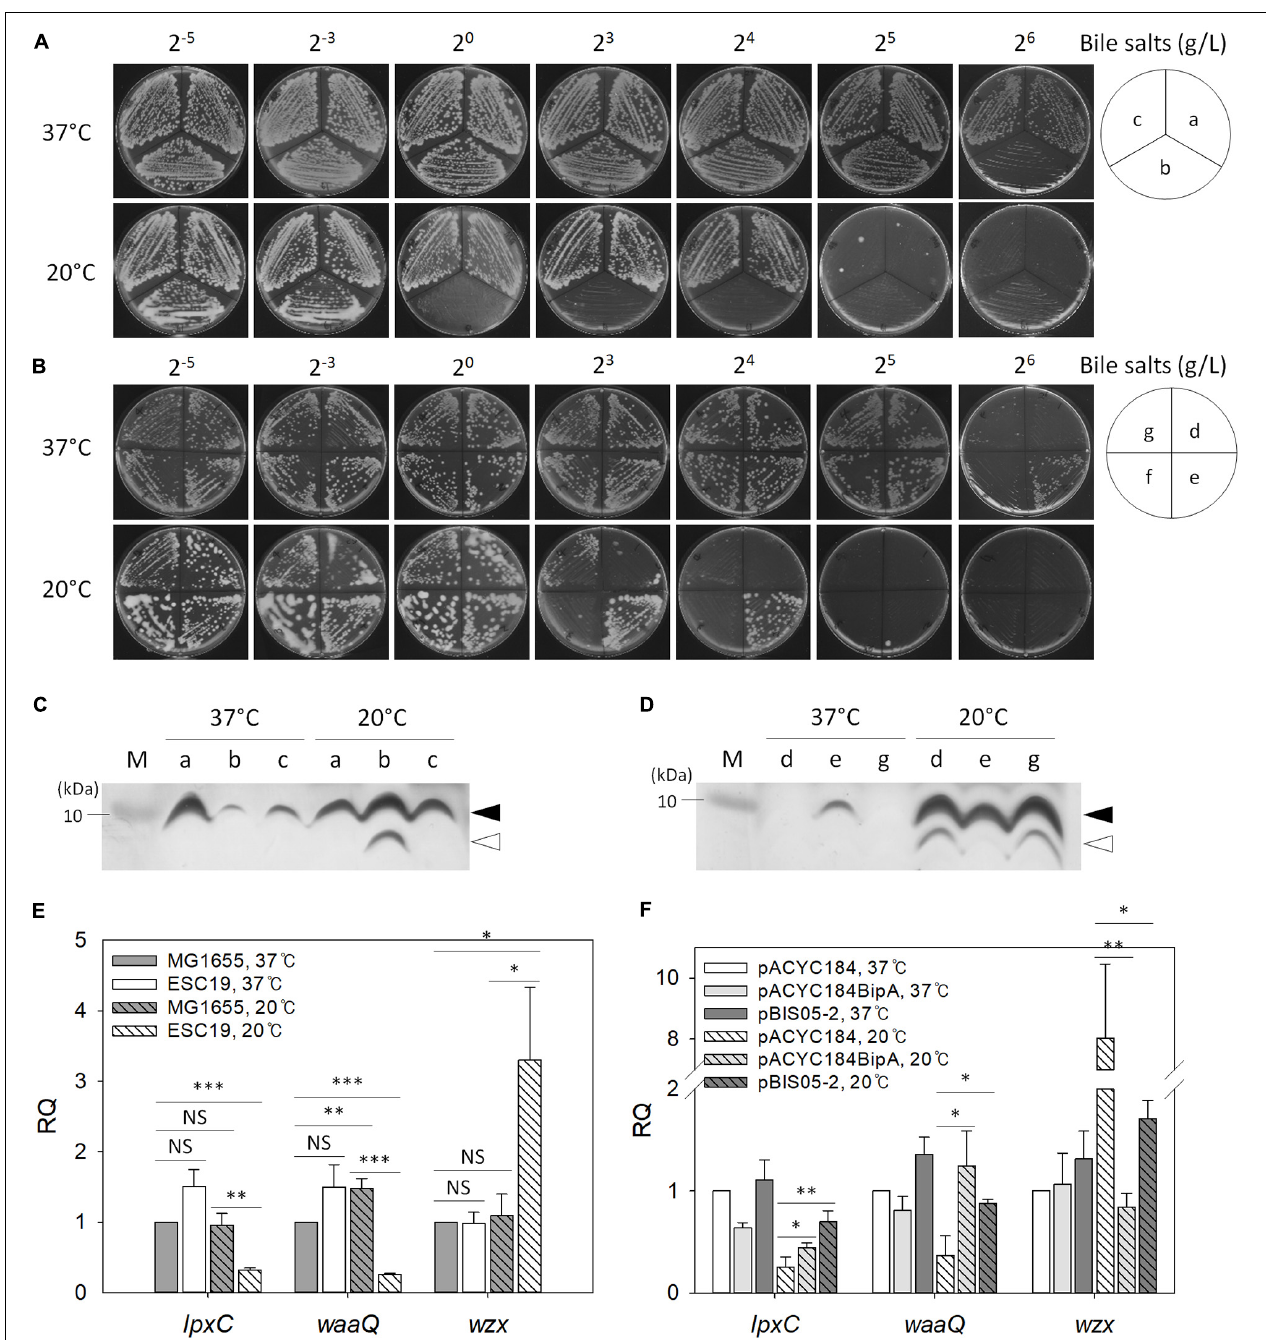
FIGURE 5 | The effect of bipA -deletion on LPS biosynthesis. Overnight cultures of the MG1655, ESC19, and ESC48 strains (A) or the ESC19 transformants with pACYC184, pACYC184BipA, pBIS02-2, or pBIS05-2 (B) were diluted with LB medium to an OD 600 of 0.2. Then, 3 µ l of the diluted cultures were streaked onto LB plates supplemented with different concentrations of bile salts as presented above, after which the plates were incubated at 37 ◦ C or 20 ◦ C. The media for transformants contained chloramphenicol and kanamycin. (a) , MG1655; (b) , ESC19; (c) , ESC48; (d) , ESC19 with pACYC184; (e) , ESC19 with pACYC184BipA; (f) , ESC19 with pBIS02-2, and (g) , ESC19 with pBIS05-2. (C,D) Tricine SDS-PAGE analysis of LPS. LPS was extracted as described in section “Materials and Methods” and subjected to 12.5% Tricine-polyacrylamide gel electrophoresis followed by silver staining. M, PageRuler TM Unstained Protein Ladder (Thermo Fisher Scientific TM ). Alphabetical labels are the same as in (A,B) . Filled and open arrows represent mature and precursor LPS core, respectively. (E,F) Relative quantification of mRNA levels of genes involved in LPS biosynthesis. Total RNA was extracted and subjected to qRT-PCR analysis. The relative quantities of lpxC , waaQ , and wzx were normalized to that of the endogenous control gene gapA . Error bars denote the SD using three experimental replicates. NS, non-significant; ∗ p < 0.05; ∗∗ p < 0.01; ∗∗∗ p < 0.001.